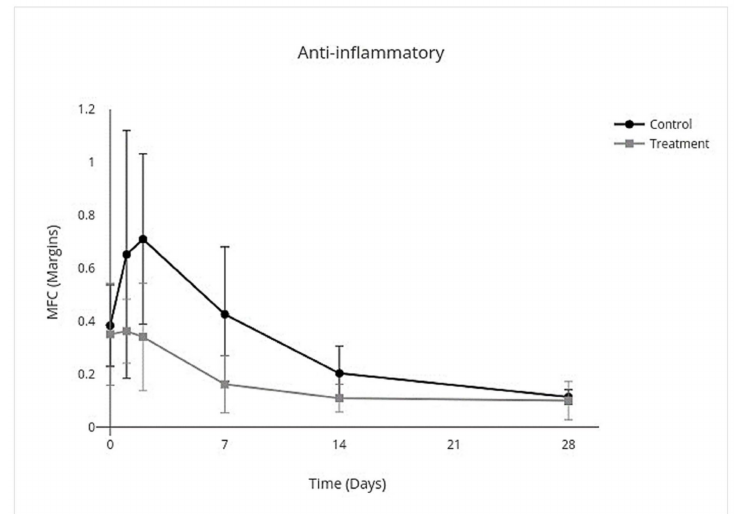
Figure 8. MFC of mRNA expression of anti-inflammatory cytokines over time following IV allo- CB-MSC therapy. In the treatment group, there was an overall treatment effect over all days, characterized by decreased expression of anti-inflammatory cytokines with no significant treatment effect on individual